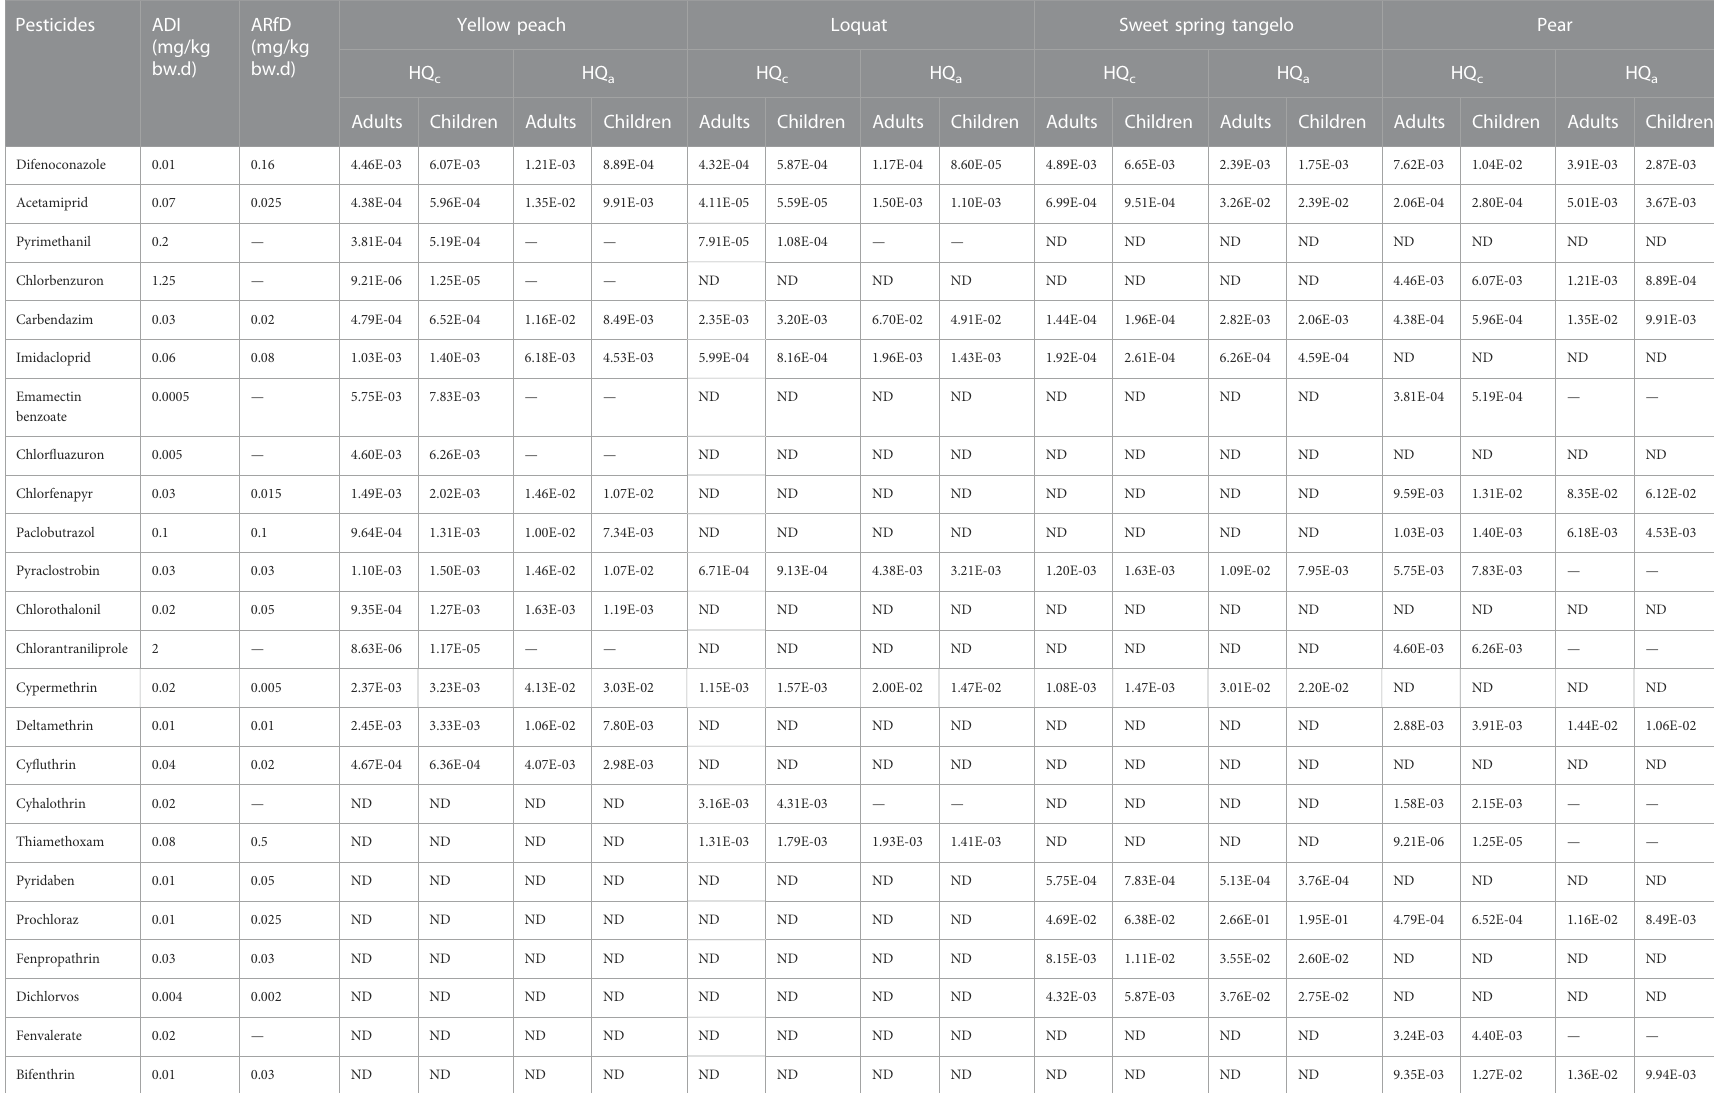
TABLE 2 Long- and short-term risk assessment of pesticide residues in the four fruit types. Pesticides